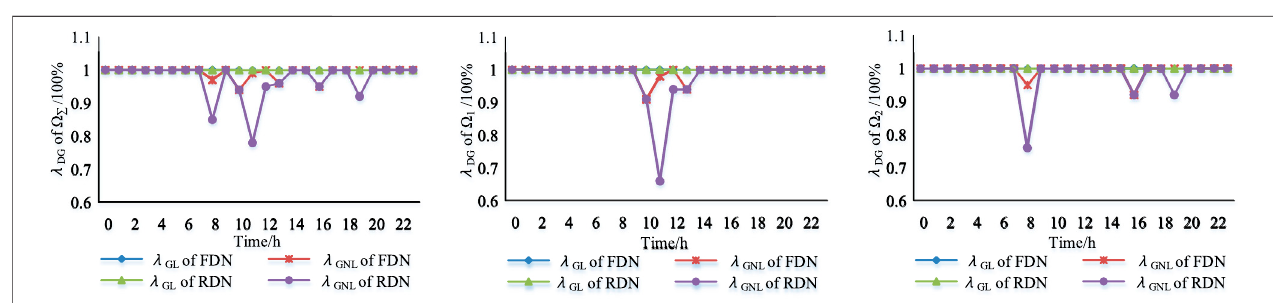
FIGURE 9 | Scenario 3: daily GLAR and GNLAR curve of both the FDN case and RDN case.